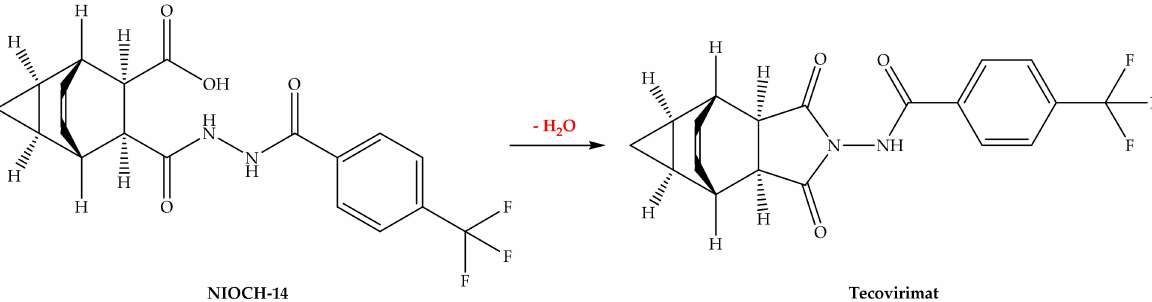
Figure 4. Metabolism of NIOCH-14.